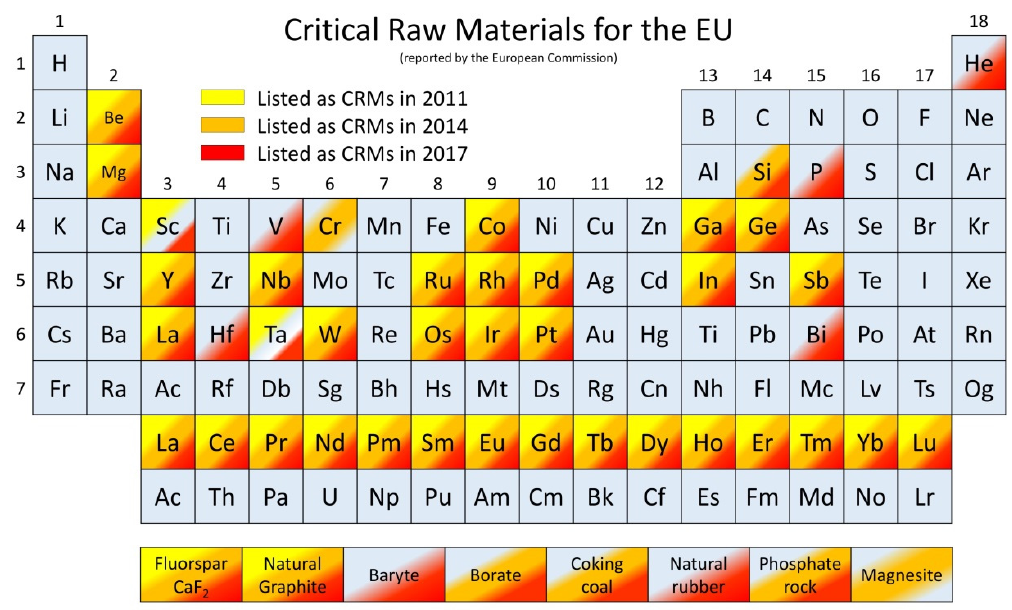
Figure 2. Critical raw materials list for 2011–2017 overlaid on the periodic table of the elements [5,6].